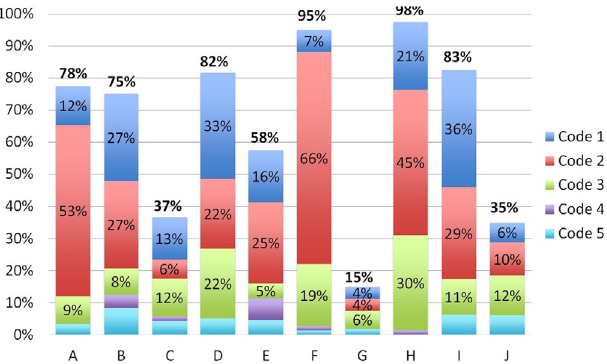
FIG. 4. The composition of social positions for each group in “ roller coaster ” activity, episode 2. Columns represent percentage of 1, 2, 3, 4, and 5 codes as a fraction of total number of codes, scaled by the amount of coded